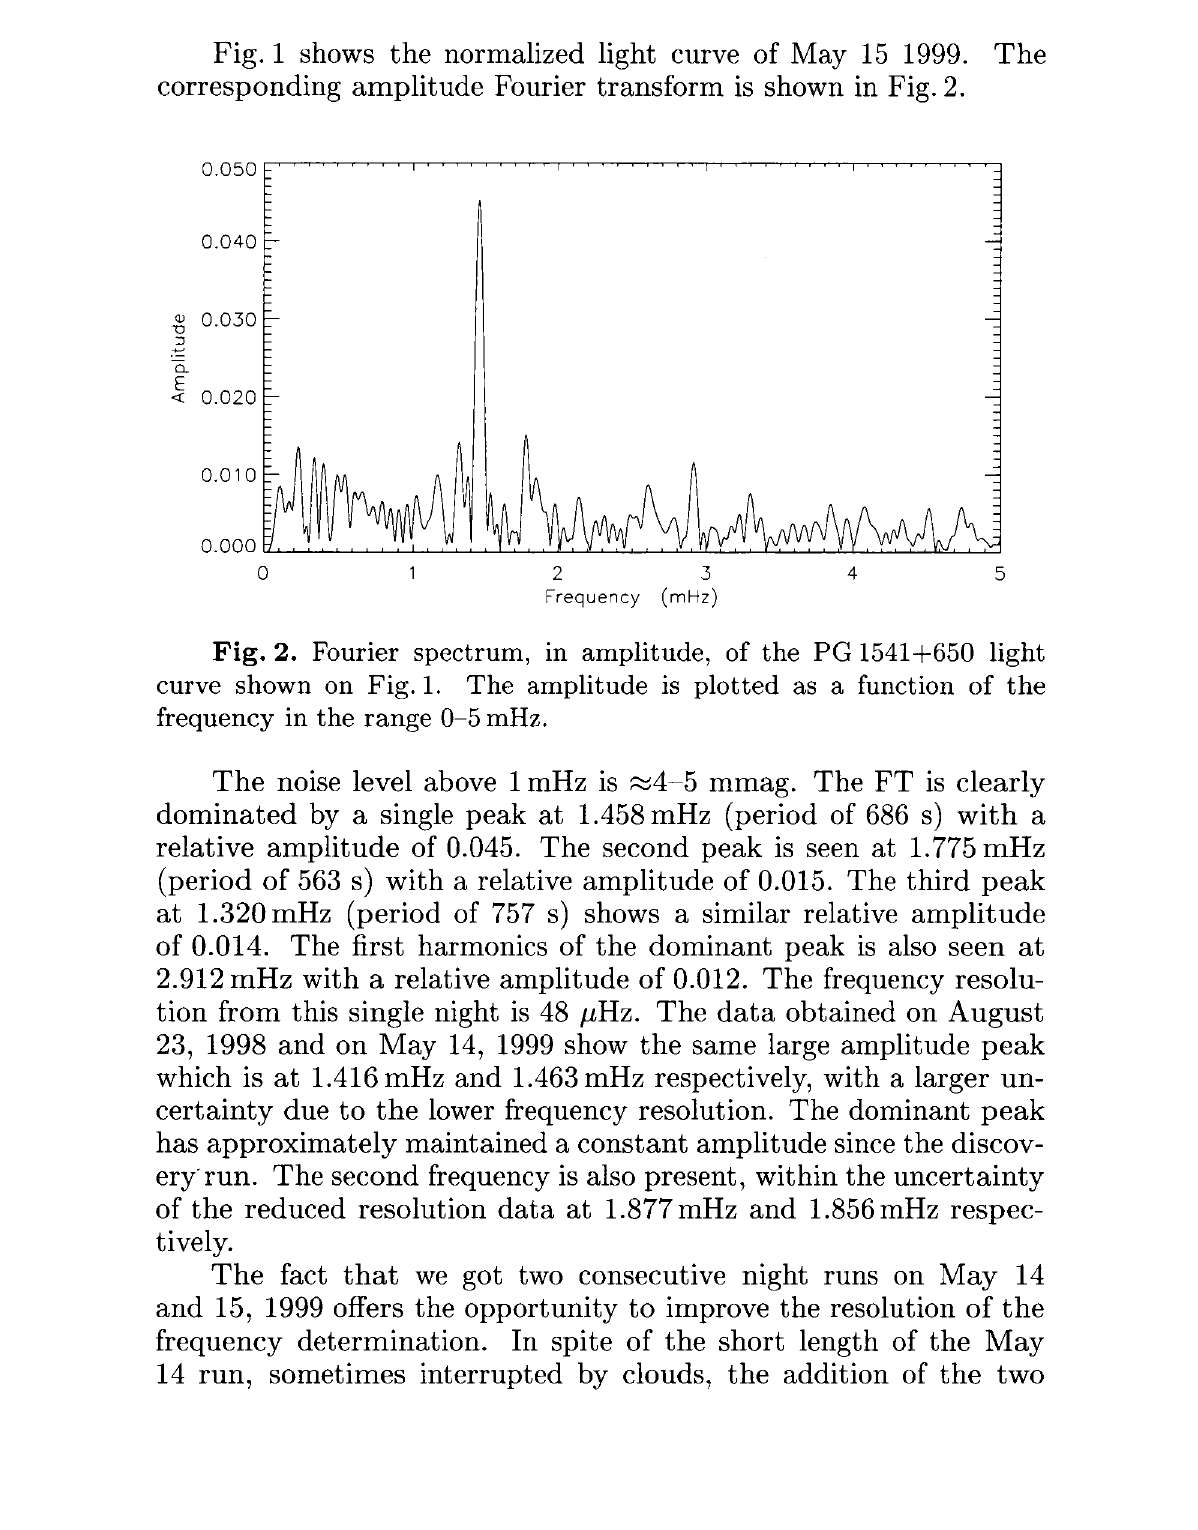
Fig. 1 shows the normalized light curve of May 15 1999. The corresponding amplitude Fourier transform is shown in Fig. 2.